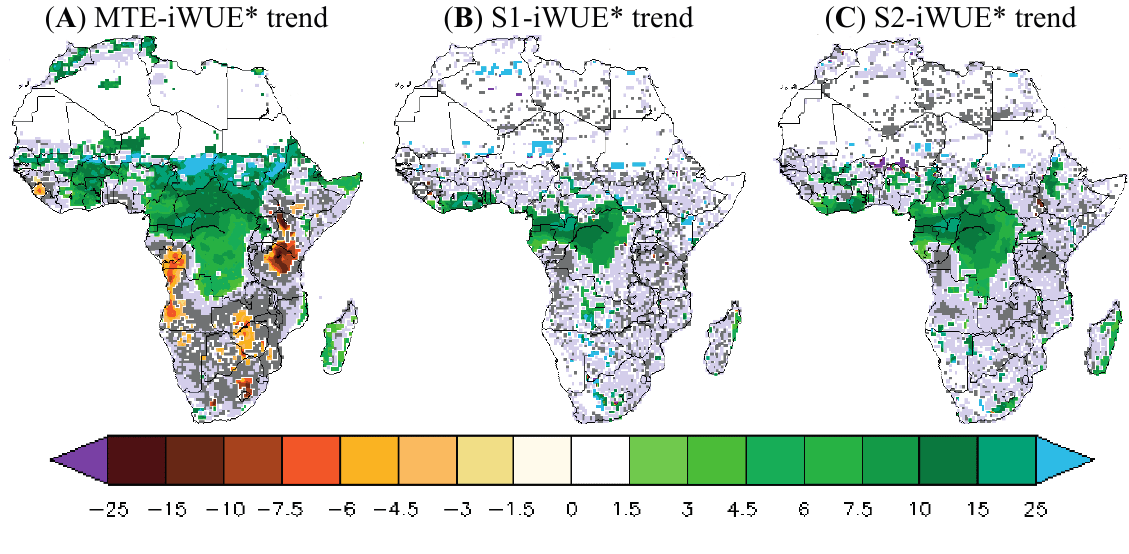
Figure 3. 1982–2010 trends of iWUE* (% of iWUE*): ( A ) iWUE* calculated from MTE-GPP and MTE-ET product with VPD from WFDEI CF; ( B ) iWUE* trend obtained with the ORCHIDEE 11-layer version and ( C ) the 2-layer version. Same color code than Figure